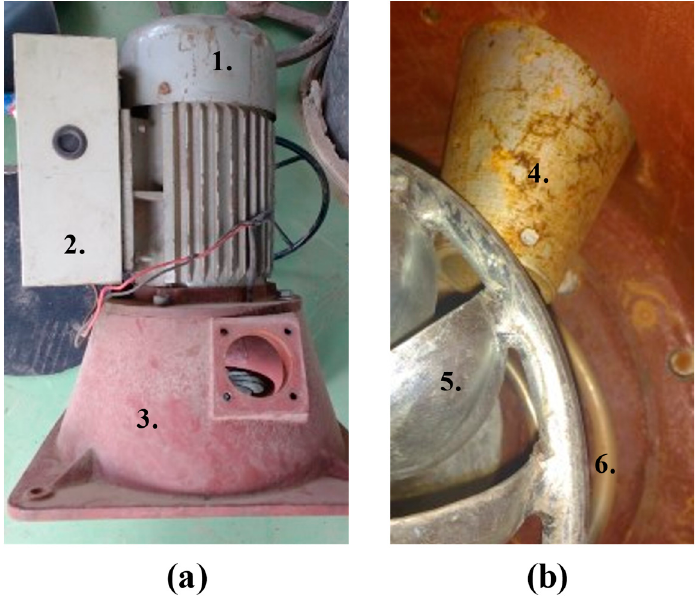
Figure 4. Imported Turgo turbine set including ( a ) 1. induction motor, 2. electronic load controller, 3. turbine casing, and ( b ) 4. nozzle, 5. Runner, and 6. ballast heating element.